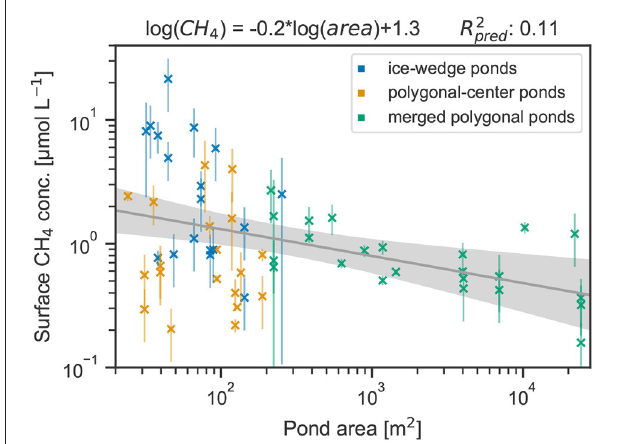
FIGURE 7 | Linear regression between the natural logarithm of methane surface concentrations and the natural logarithm of pond area. Shaded area indicates the 95 % confidence